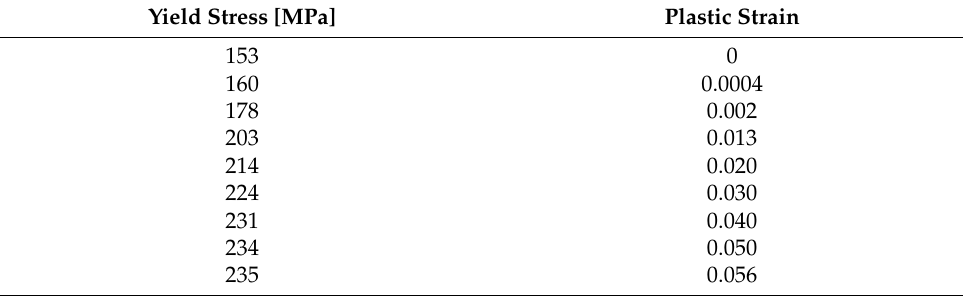
Table 3. Plastic properties of the AlSi10Mg alloy.